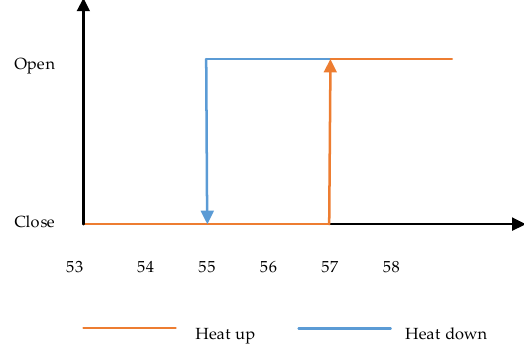
Figure 3. Control principle of diverter valve.